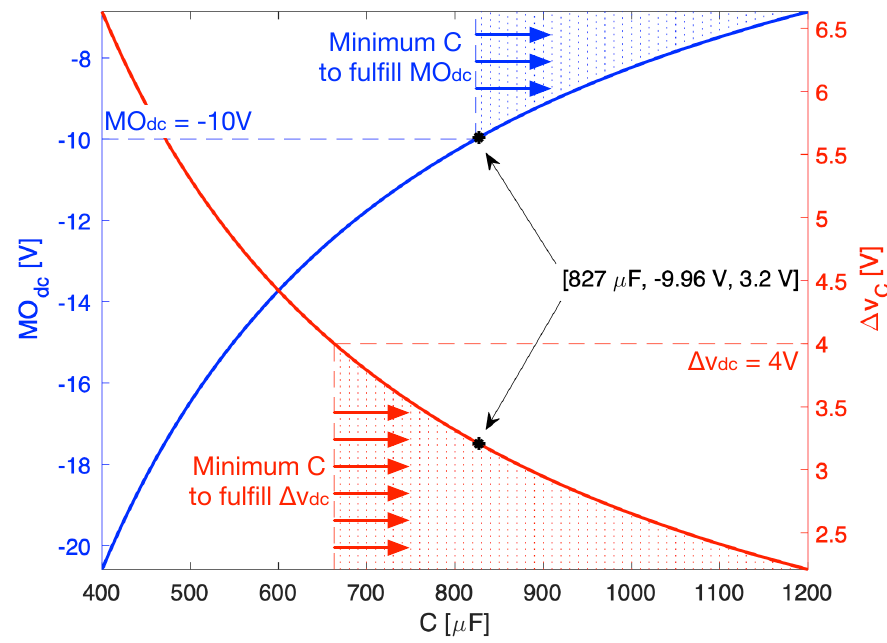
Figure 11. Design of the capacitor C